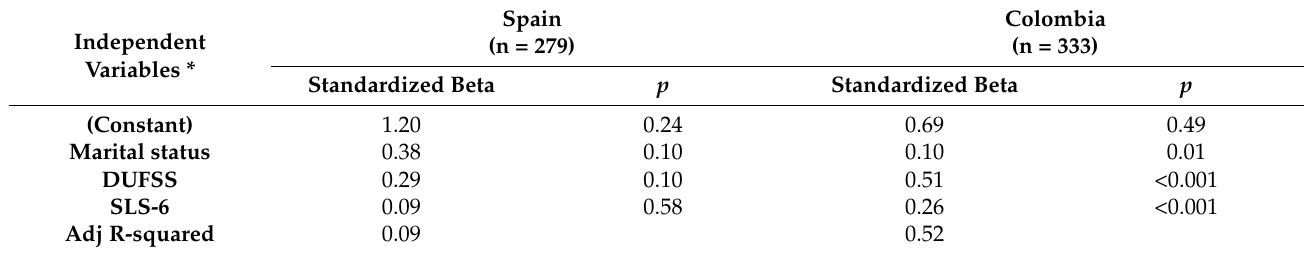
Table 4. Multiple linear regression models of LW-CI-COPD by